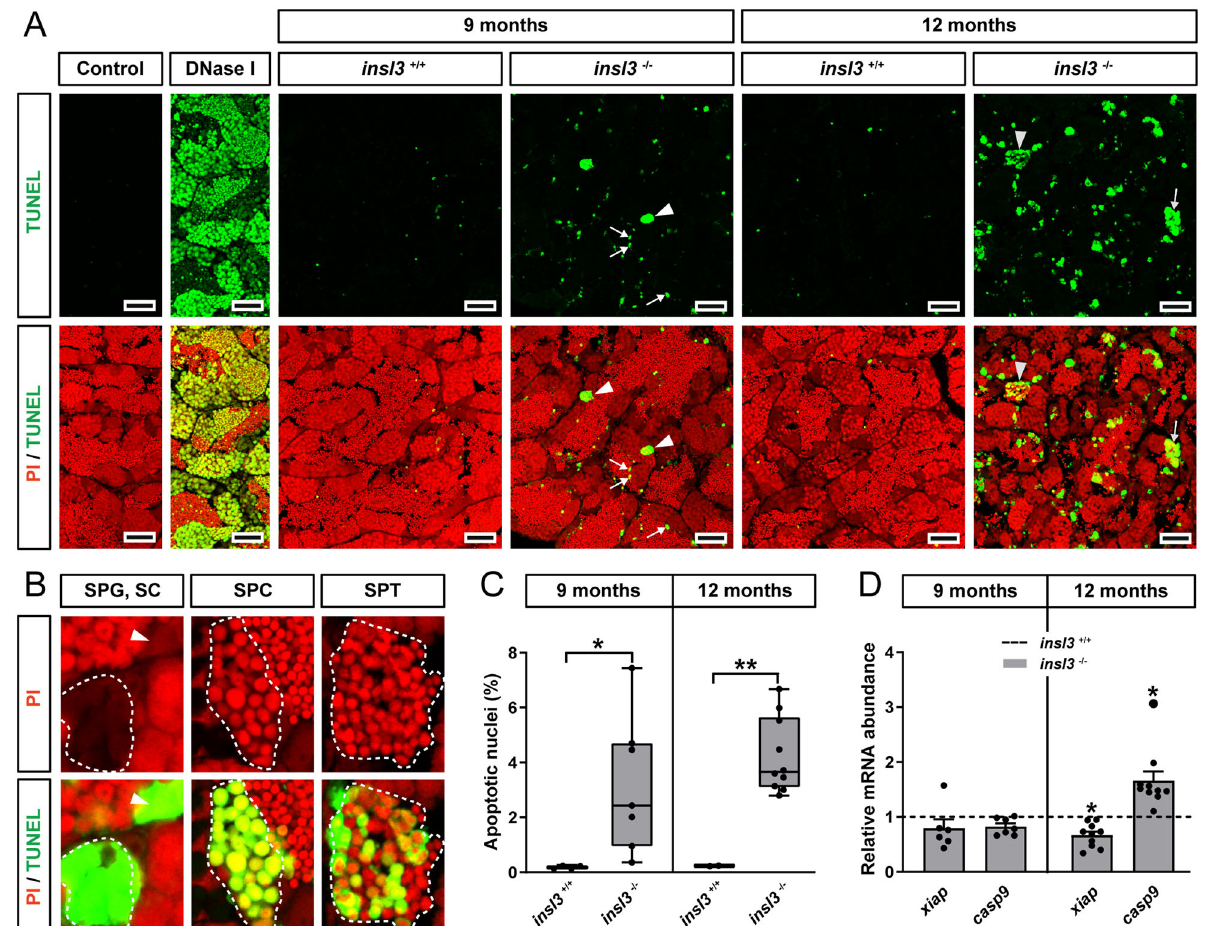
Fig. 3 Con fi rmation of germ cell apoptosis/DNA damage in insl3 knockouts by TUNEL analysis. A – C Detection ( A , B ) and quanti fi cation ( C ) of germ cell apoptosis/DNA damage in wild-type ( insl3 + / + ) and insl3 knockout ( insl3 − / − ) testes 9 and 12 months post-fertilization. In A , white arrowheads and arrows indicate representative TUNEL + spermatogonia and Sertoli cells, and gray arrowheads and arrows indicate representative TUNEL + spermatids and spermatocytes, respectively. In B , representative TUNEL + spermatogonia (SPG), spermatocyte (SPC) or spermatid (SPT) cysts are encircled with a white dashed line, and a TUNEL + Sertoli cell (SC) is indicated by a white arrowhead. TUNEL + cells/cysts are shown in green and propidium iodide (PI) counterstain is red. Scale bars, 25 µ m. D Transcript levels of anti- ( xiap ) a pro-apoptotic ( casp9 ) genes in insl3 + / + and insl3 − / − testis tissue 9 and 12 months post-fertilization. TUNEL quanti fi cation results are shown as mean ± SEM ( insl3 + / + and insl3 − / − , 9 months: N = 4 and 7; insl3 + / + and insl3 − / −